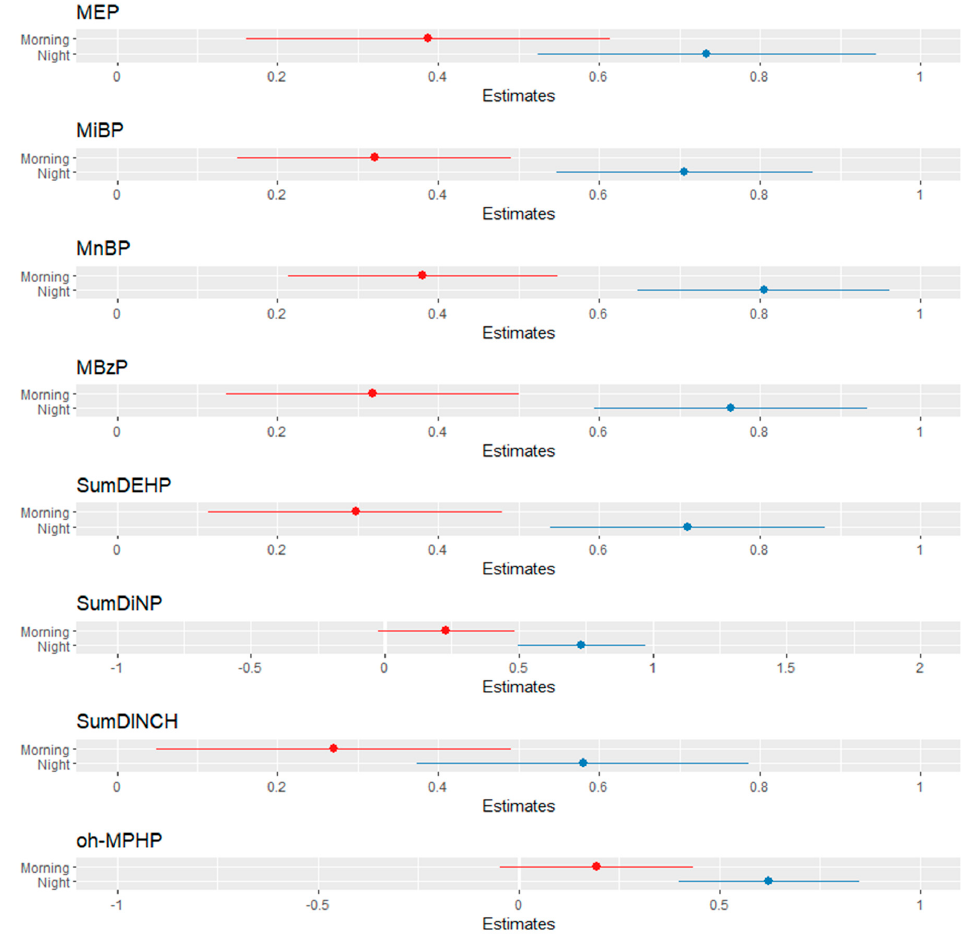
Figure 2. Forest plot visualization of the linear mixed-effect models of SG-adjusted metabolites of phthalates/DINCH as a function of time of urine sampling in the day adjusted for dietary habits and personal-care-product use (reference: mid-day = zero point).